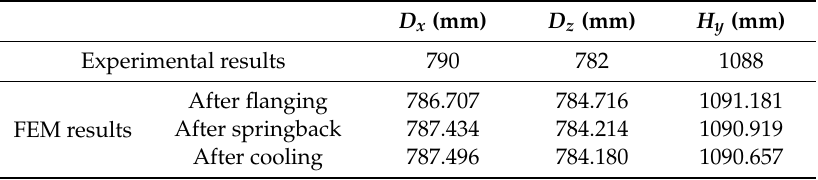
Figure 13. Representation and measurement of geometry of branch pipe: ( a ) diameter; ( b ) height; ( c ) actual measurement. Table 4. Comparison of geometrical parameters between FEM and